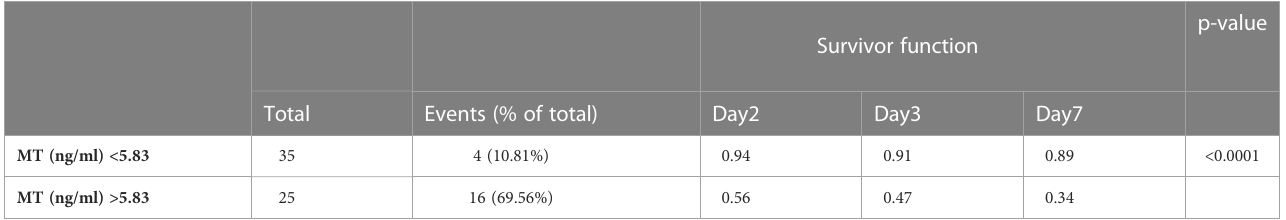
TABLE 8 Kaplan Meier analysis for metallothionein levels (MT) (cut-off 5.83 ng/mL) in the 20 ACLF patients who progress to AKI within a follow up period of 7